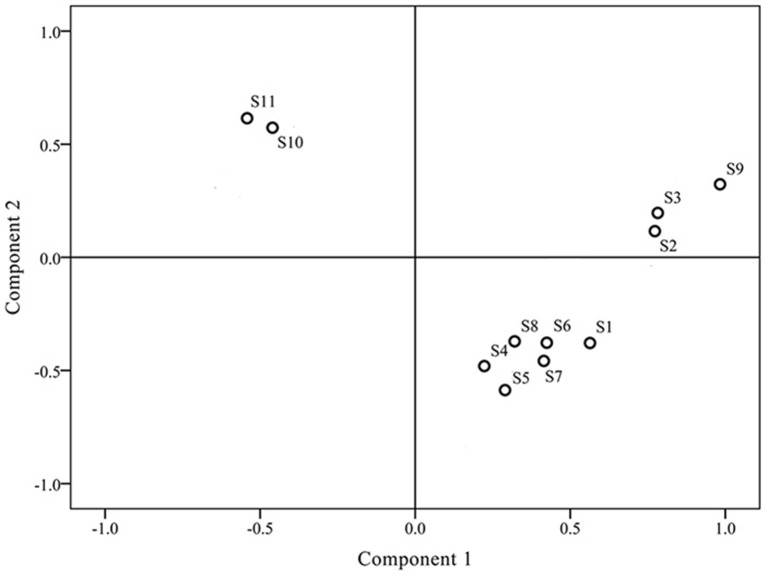
Scores plot generated from principal component analysis (PCA) of all J. rigida samples.